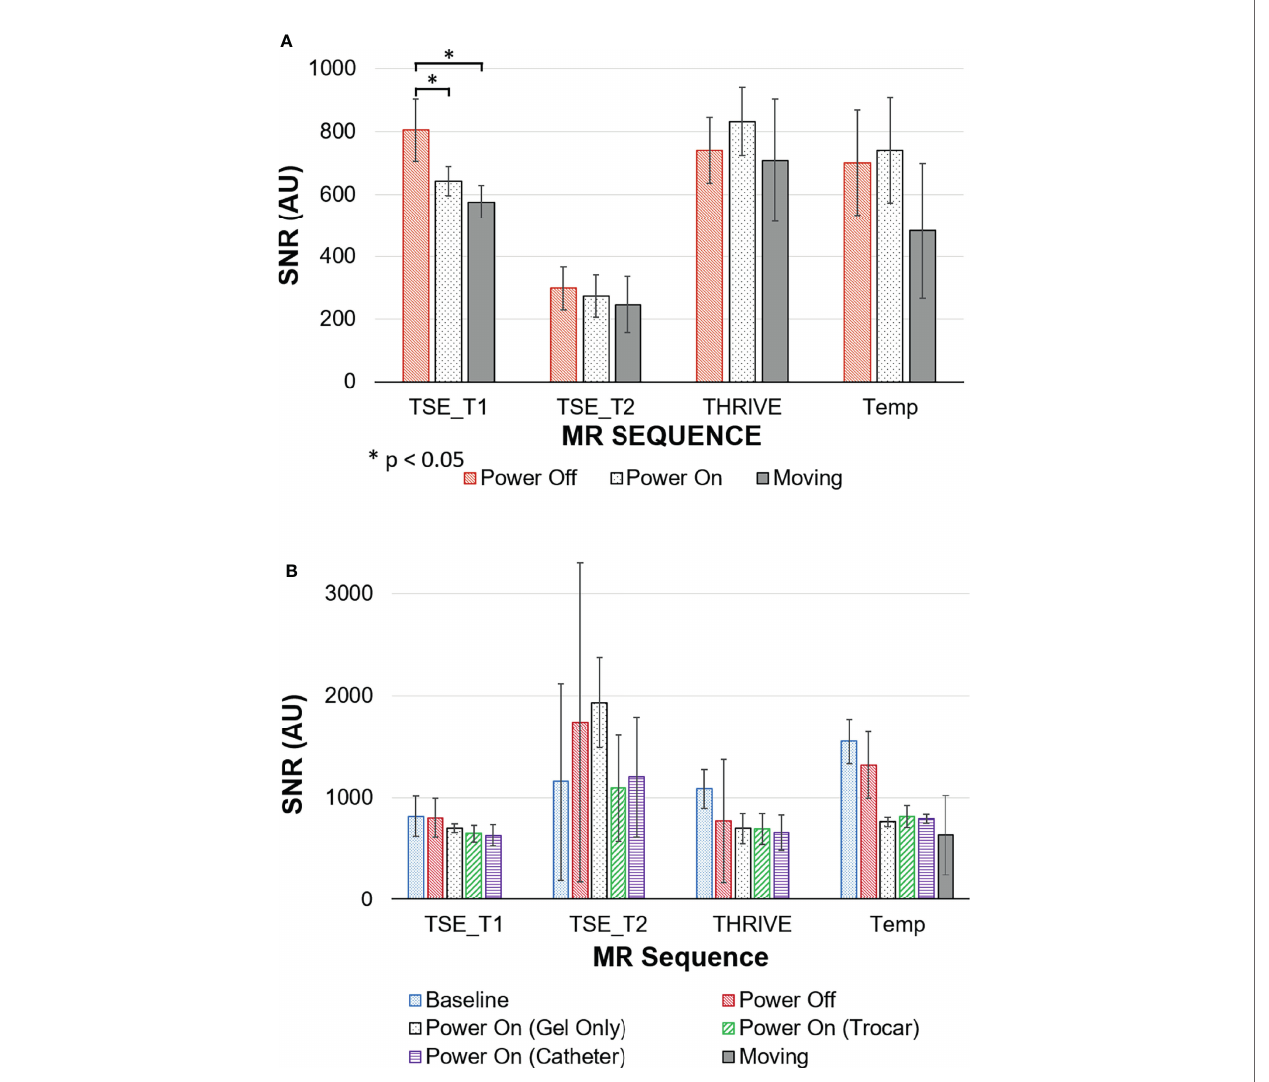
FIGURE 7 | Signal to Noise ratios (SNR) for MRI sequences with the robot in different states of use measured in (A) saline phantom; (B) gelatin